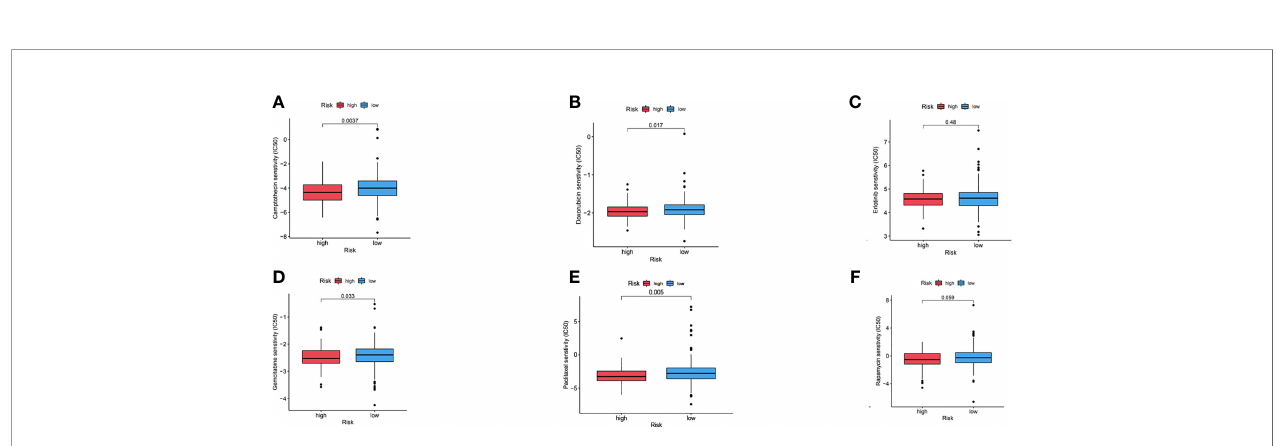
FIGURE 7 | Based on CIBERSORT, CIBERSORT-ABS, EPIC, ESTIMATE, MCP counters, QUANTISEQ, TIMER and ssGSEA algorithms, heatmap of immune in fi ltration in the high- and low-risk groups was showed.